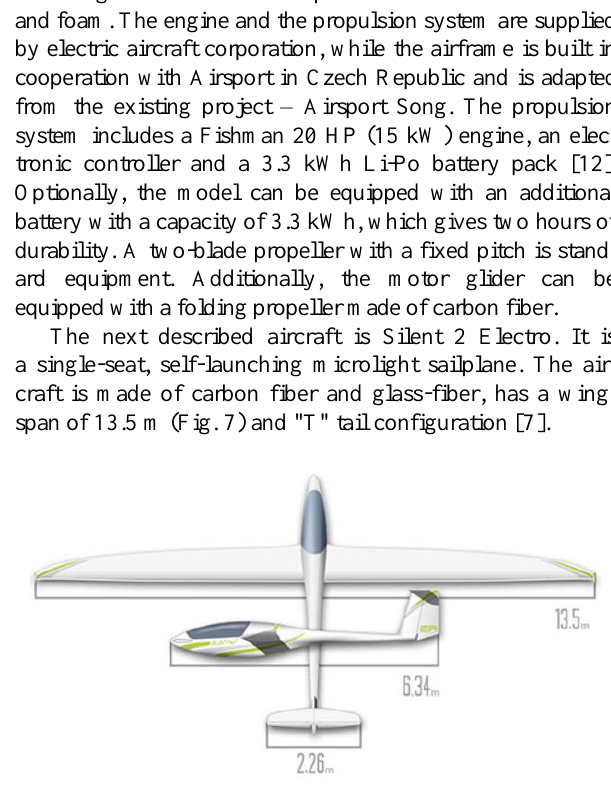
Fig. 7. Motor-glider Alisport Silent 2 dimensions [7]